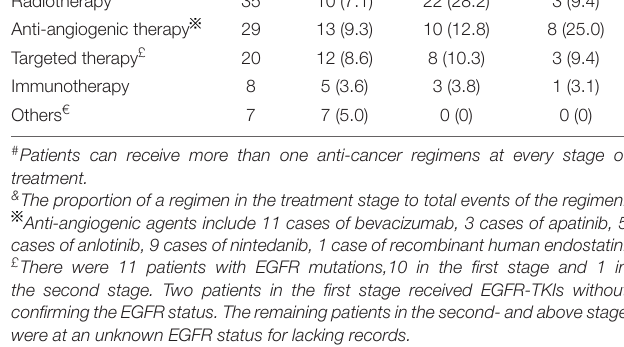
TABLE 3 | Treatment options for the anti-cancer cohort of ILD-LC stratified according to histological type, clinical stage, subtype of ILD, and ECOG-PS score. N Surgery & Chemotherapy Interventional